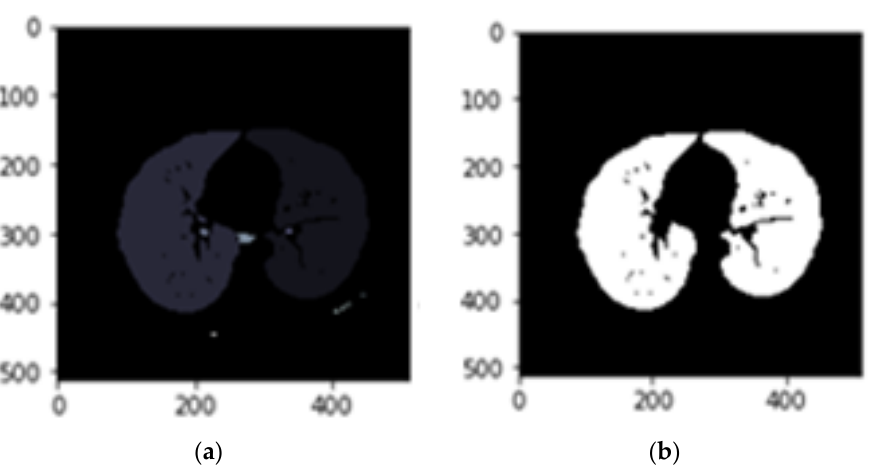
Figure 5. ( a ). Labeled image, ( b ). Image with the two largest labeled areas kept.